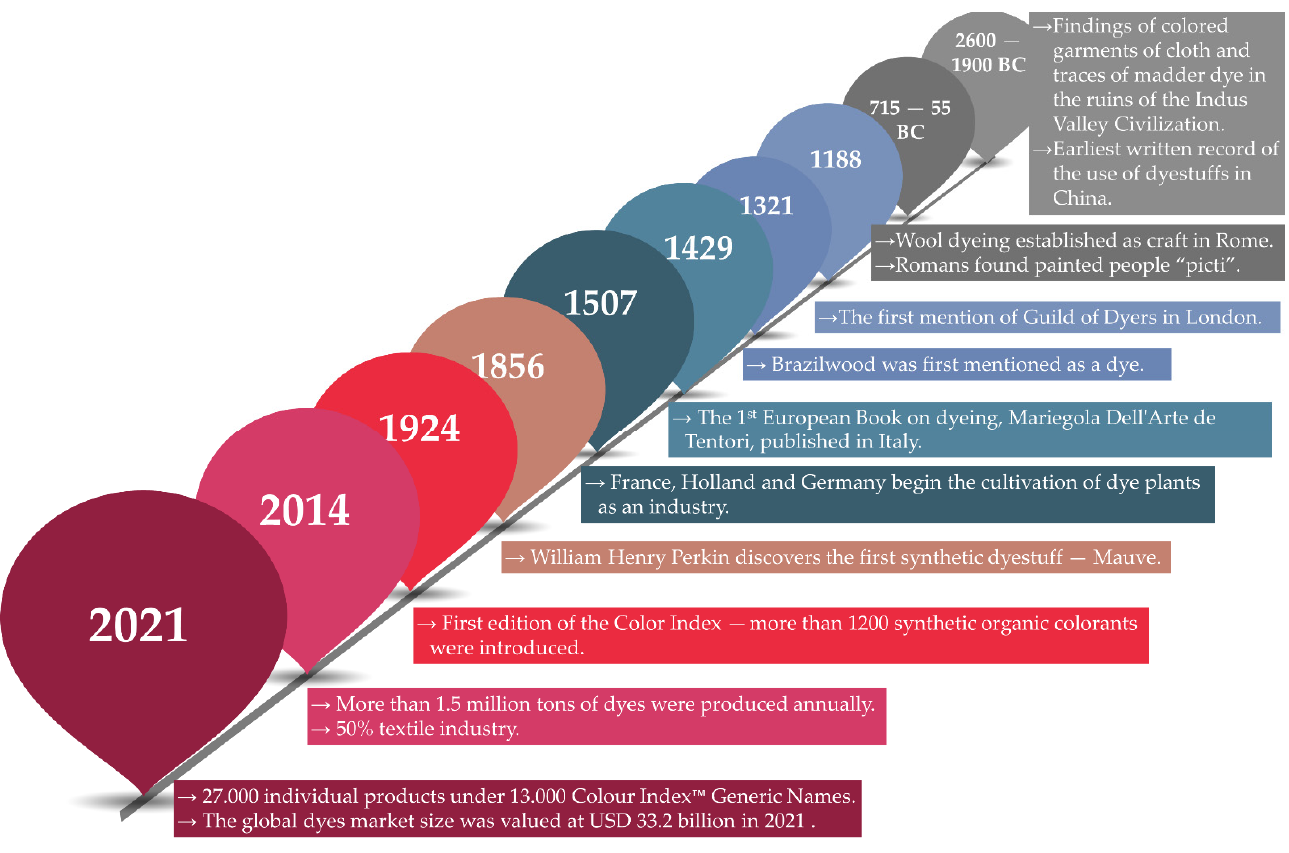
Figure 1. Historical timeline of dye usage, invention and interesting